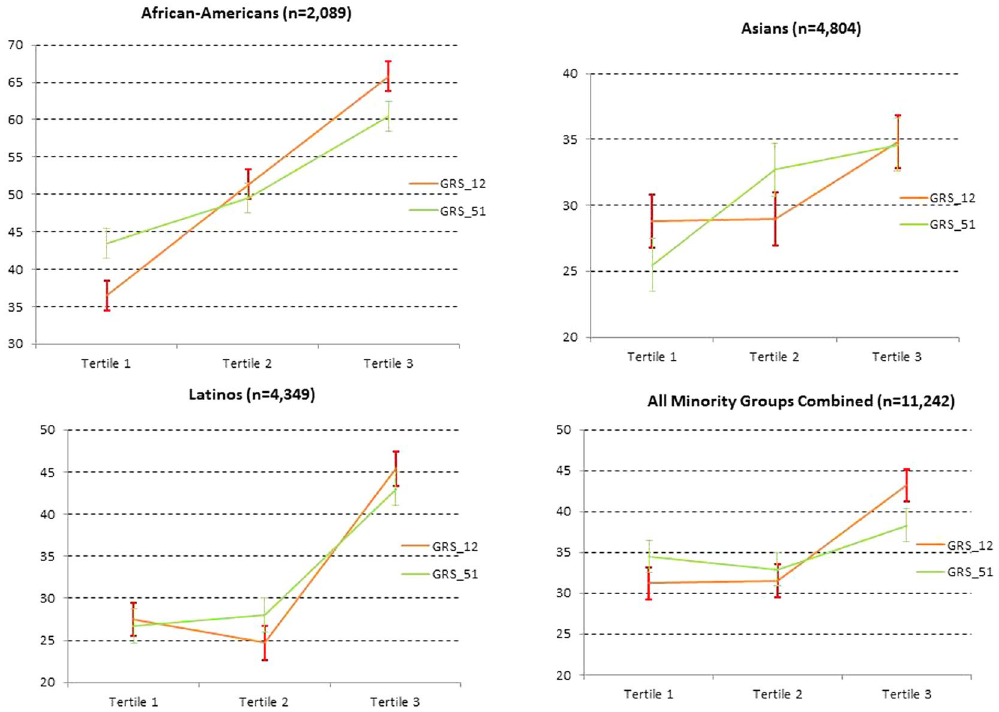
Figure 2. Age-adjusted rates of incident CHD according to quintiles of GRS_12 and GRS_51. Bars denote standard